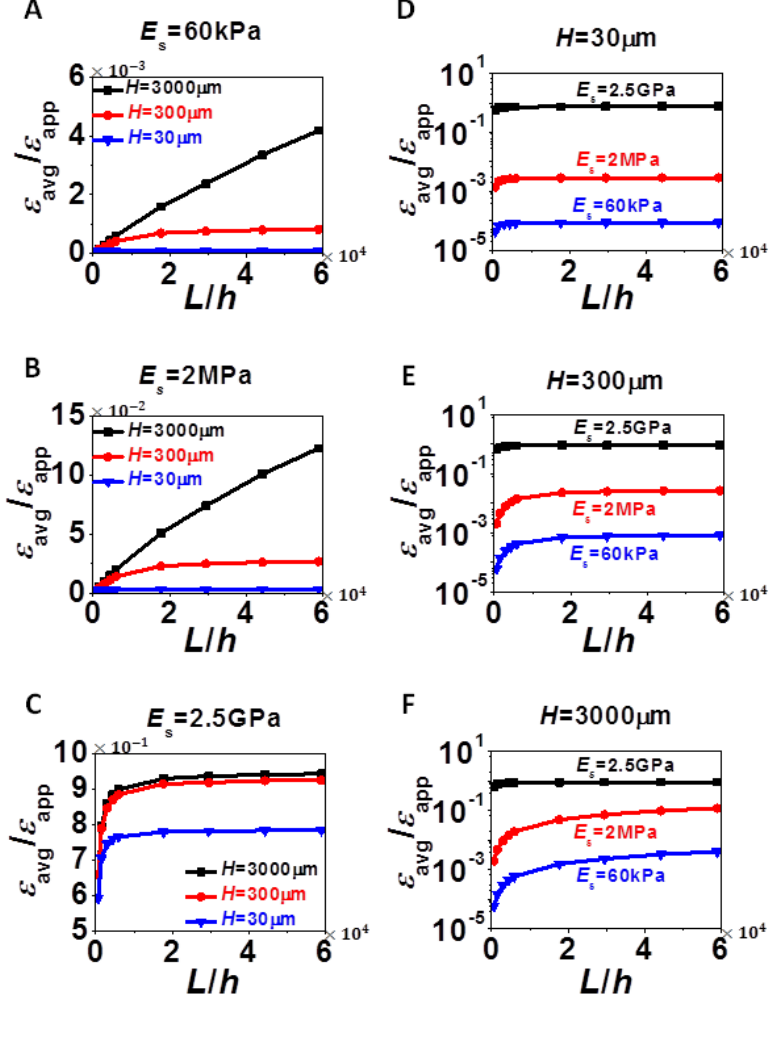
Figure 3. Normalized average strains in silicon as a function of normalized silicon length for various combinations of H and E . ( A ) Ecoflex substrate: E = 60 kPa. ( B ) 10:1 PDMS s s substrate: E = 2 MPa. ( C ) Kapton substrate: E = 2.5 GPa. ( D ) H = 30 μm. ( E ) H = 300 μm. s s ( F ) H = 3,000 μm. Average strain in silicon increases monotonically with L , H , and E s